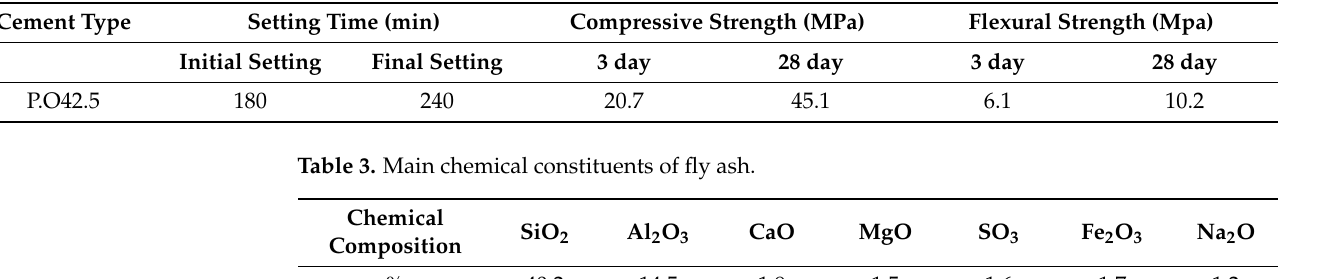
Table 2. Physical properties of ordinary Portland cement.